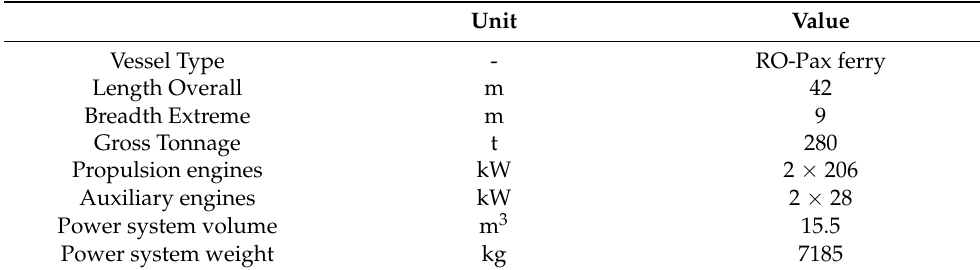
Table 2. The main characteristics of the RO-Pax ferry proposed as a case study. Power system volume and weight have been elaborated from data available on diesel storage on board and a diesel-electric generator for marine propulsion, scaled by the installed power of the